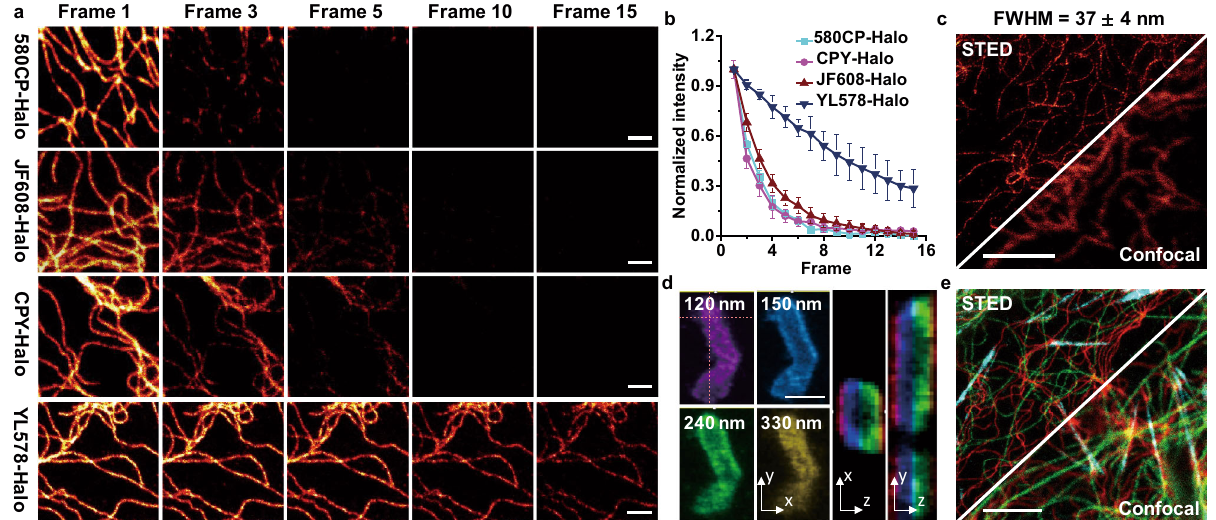
Fig. 4 Super-photostable YL578-Halo in 3D and live-cell STED microscopy. a Multiframe STED imaging of fi xed U-2 OS vimentin-HaloTag-expressing cells labeled with 50 nM CPY-Halo, JF608-Halo, 580CP-Halo and YL578-Halo respectively (STED at 775 nm). Scale bar, 1 μ m. b Normalized fl uorescence intensities of vimentin fi laments labeled with CPY-Halo, JF608-Halo, 580CP-Halo, and YL578-Halo plotted as a function of frame numbers in STED images. Error bars, ±s.e.m. 50 cells were examined in three independent experiments separately. c Confocal and STED images of live U-2 OS stably expressing vimentin-HaloTag-expressing cells labeled with 50 nM YL578-Halo . Scale bar, 5 μ m. d 3D STED images of mitochondria in U-2 OS cells expressing Tomm20-Halo labeled with 50 nM YL578-Halo . The images were recorded in sequential xzy -scanning mode. STED images recorded along the z -axis with a step of 35 nm were shown in different colors. Dashed lines indicate the position of XZ and YZ cross sections shown in the right image panel. Scale bar, 1 μ m. e Three-color confocal and STED images of live U-2 OS Vimentin-HaloTag-expressing cells labeled with 500 nM YL578-Halo (red, STED at 775 nm), 500 nM MaP555-actin (cyan, STED at 775 nm) and 500 nM GeR-tubulin (green, STED at 775 nm). Scale bar, 5 μ